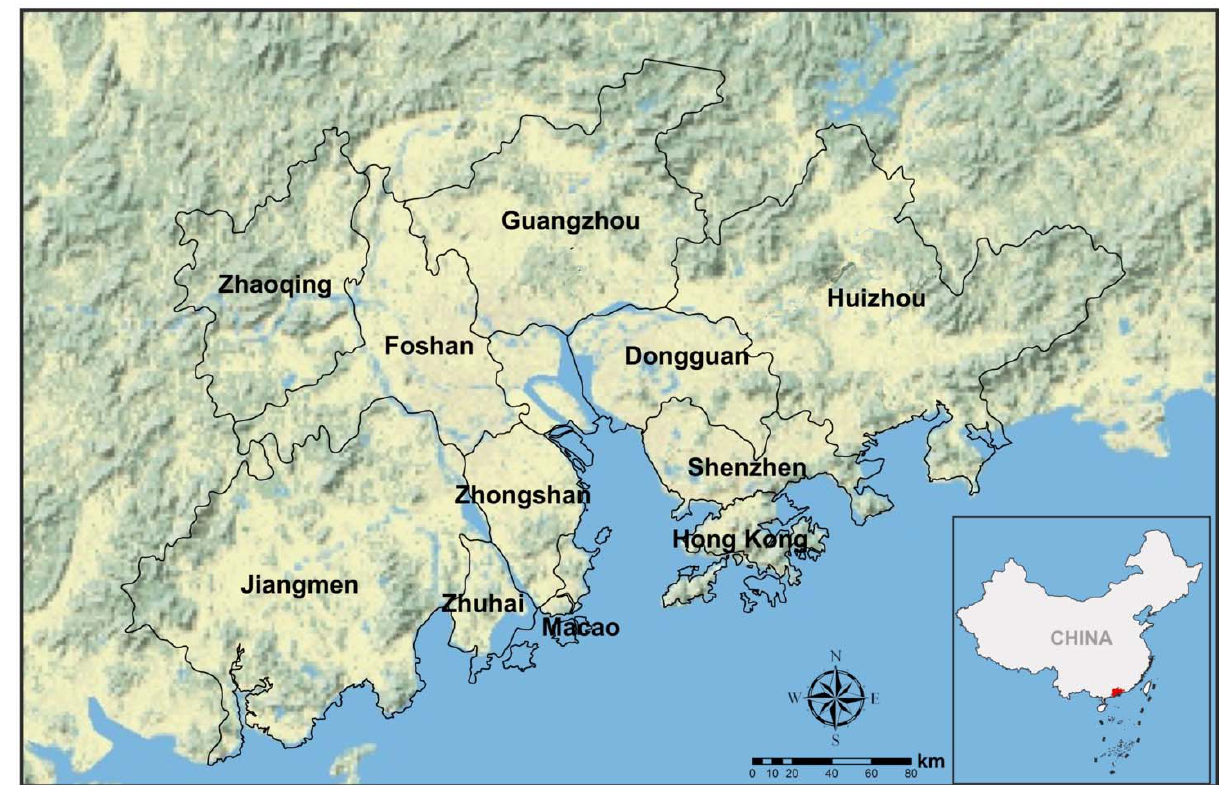
Figure 3. The study area (relative location of the Pearl River Delta Region (PRDR) in China and 11 cities in this region).